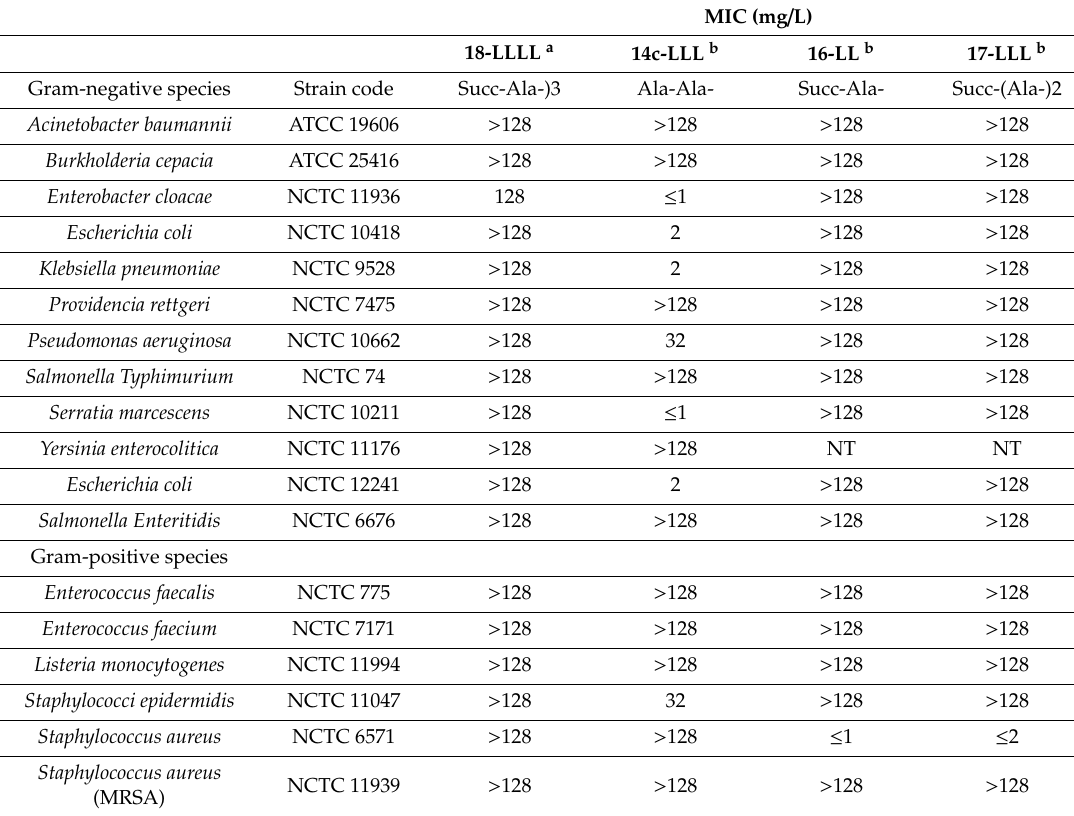
Table 3. MIC values of C-terminal 1-aminoethyltetrazole containing oligopeptides; NT: not tested; a: inoculum 150000 CFU / spot; b: inoculum 10000 CFU /